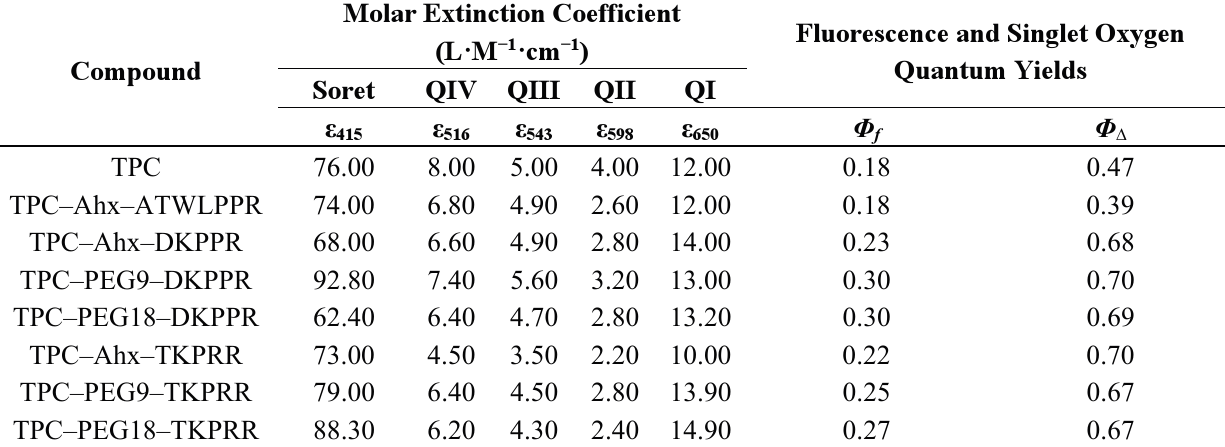
Figure 4. Absorption spectra ( a ), fluorescence emission ( b ) and singlet oxygen emission spectra ( c ) for TPC–PEG9–TKPRR in ethanol. Table 3. Molar extinction coefficients of TPC and novel TPC–peptide